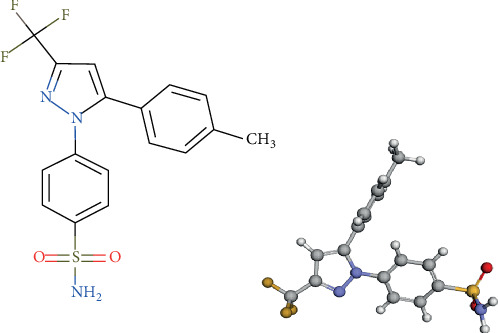
Chemical structure for CXB.